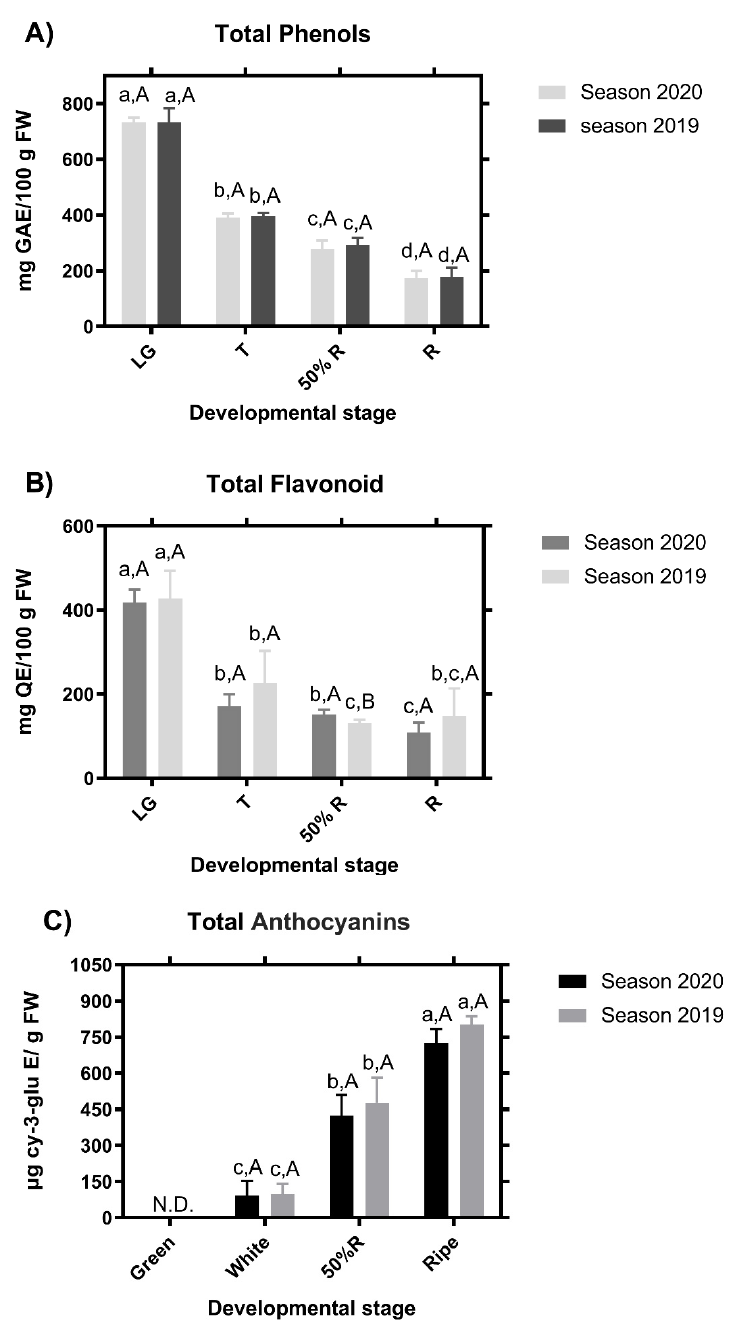
Figure 4. Chemical analysis of the stage of blackberry ( Rubus ulmifolius Schott) fruit in two different seasons. Total phenols ( A ), flavonoids ( B ), and anthocyanins content ( C ). N.D.—not detected. GAE—gallic acid equivalent; Cy-3-glu–cyanidin-3- O -glucoside; QE—quercetin equivalent. Different capital letters indicate significant differences between the four development and ripening stages. Different lowercase letters indicate significant differences in each season (2019 and 2020) over four de- velopment and ripening stages. Differences between means ± standard errors (SE) were determined by ANOVA and the LSD test ( p <